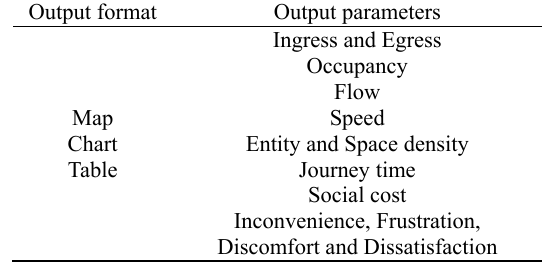
Table.1 Output parameters of Legion